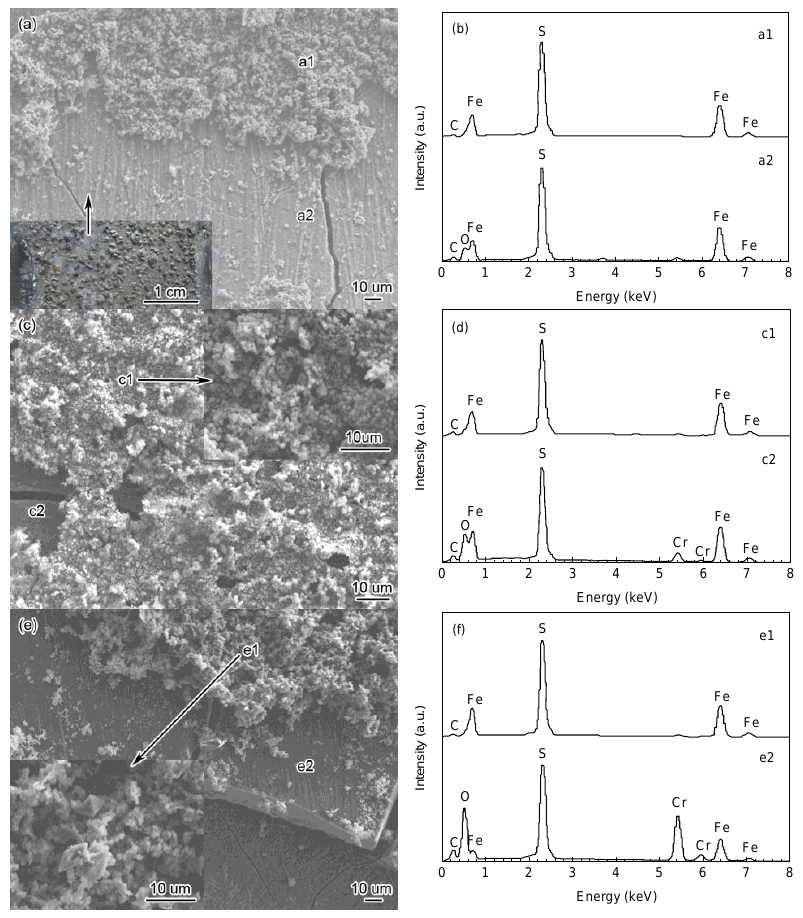
Figure 4. ( a , c , e ) Scanning electron microscope (SEM) images and ( b , d , f ) energy dispersive spectroscopy (EDS) analysis of the surface products on (a,b) P110; (c,d) 3Cr-P110 and (e,f) 5Cr-P110 tube steels in 3.5 wt % NaCl solution with CO 2 and H 2 S: (b) denoted by a1 and a2 in (a); (d) denoted by c1 and c2 in (c) and (f) denoted by e1 and e2 in (e) ( P CO2 = 5 MPa, P H2S = 0.2 MPa, 90 °C, 1 m/s, 360 h).